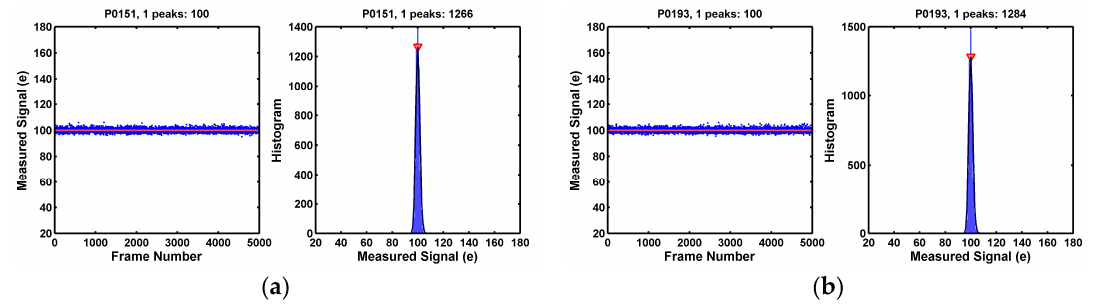
Figure 6. ( a , b ) Two example pixels showing one histogram peak with small RMS noises. These pixels do not appear to have any RTN traps. They account for a majority of the 8.3 Mpixels, more than 95% of the population, on the lower noise end of the distribution. A set of selected 1000 pixels are labelled from “P0001” to “P1000”.